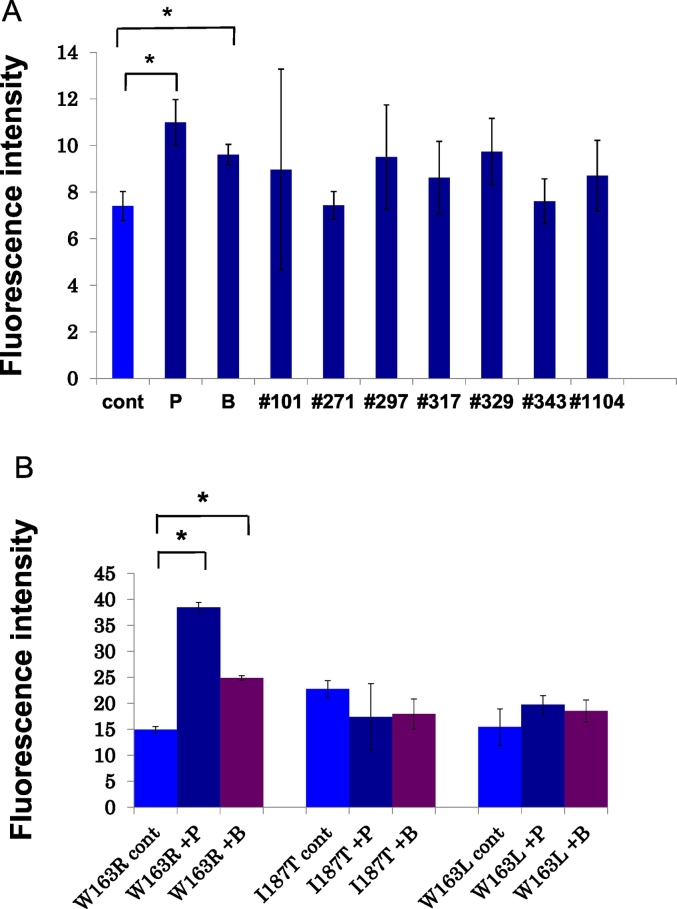
The results of analyses of the cell membrane localization of PLP1-EGFP and the EGFP intensities of PLP1 mutants with chemicals are shown. (A) The EGFP fluorescence intensities of PLP1A243V in the cell membrane after the addition of 9 chemicals extracted in the first step were analyzed with an In Cell Analyzer 1000®. Among these, piracetam (P, P = 0.01) and benserazide (B, P = 0.009) significantly increased the fluorescence intensity at the cell membrane. The intensity of the other seven chemicals (#101, apomorphine; #271, vincamine; #297, benzydamine; #317, guanethidine; #329, tacrine; #343, desipramine; #1104, clonixin lysinate) was not markedly affected. (B) The EGFP fluorescence intensity of PLP1W163R, PLP1I187T, and PLP1W163L at the cell membrane after the addition of piracetam and benserazide. Both chemicals significantly increased the fluorescence intensity at the cell membrane in PLP1W163R. *P < 0.05. Error bar: mean ± SE.